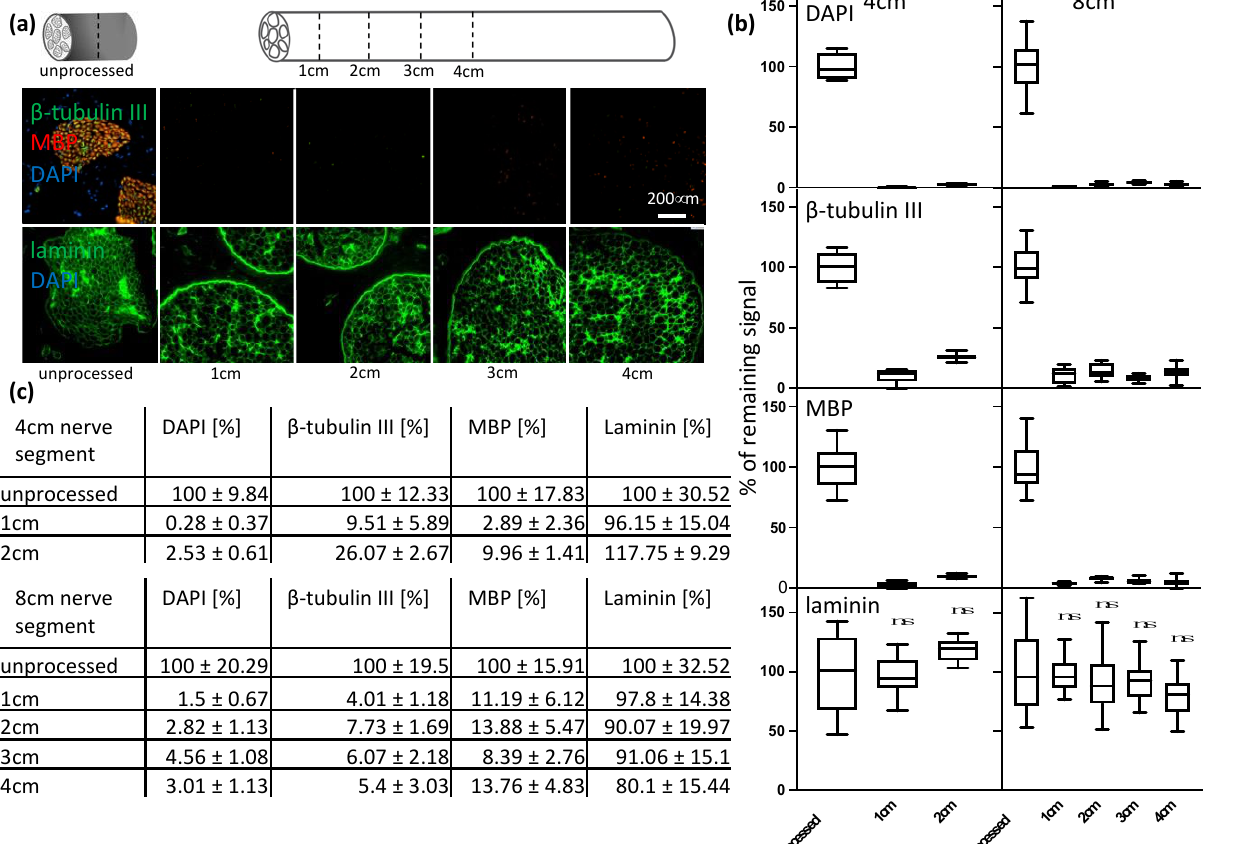
Figure 3. Quantification of remaining cellular components in longer nerve segments. ( a ) The remaining immunogenic material and laminin structure were analyzed every 1 cm up to the middle of an 8 cm-long pig sciatic nerve segment decellularized by protocol 5. Representative images: the remaining ECM laminin structure and DAPI are shown in the upper row, together with the remaining axonal β -tubulin III, MBP and DAPI signals in the bottom row (scale: 200 µ m). ( b ) Graphic documentation: the remaining axonal β -tubulin III, MBP, DAPI and laminin signals were quantified. Fascicles were manually segmented and the remaining signals were normalized to signal unprocessed tissue. For statistical analysis, a one-way ANOVA was performed. Adjusted p -value: < 0.0001 = ****. ns: no significant differences. ( c ) Numerical documentation: percentage of the remaining axonal β -tubulin III, MBP, DAPI and laminin signals for 4 cm and 8 cm-long segments every 1 cm until the middle.